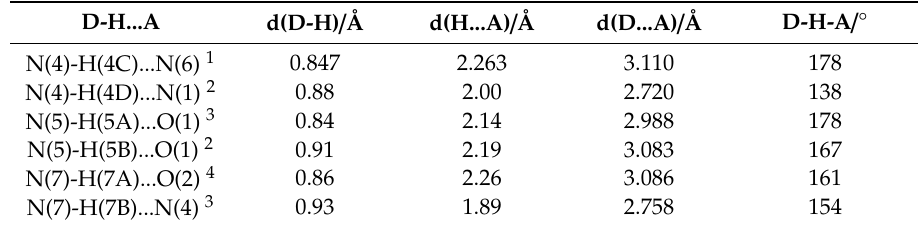
Table 1. Hydrogen bonds for